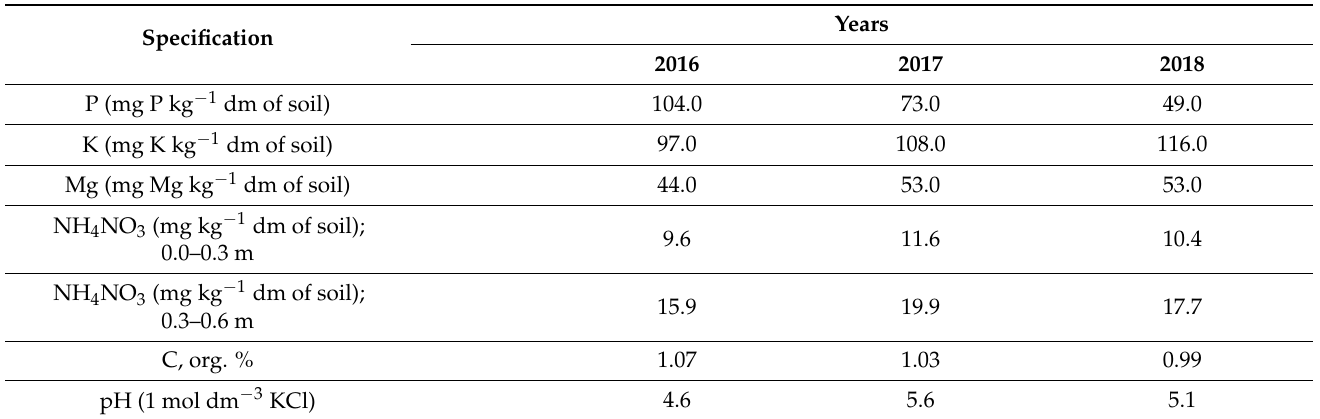
Table 3. Nutrient contents and soil pH before establishing the experiment in maize growing